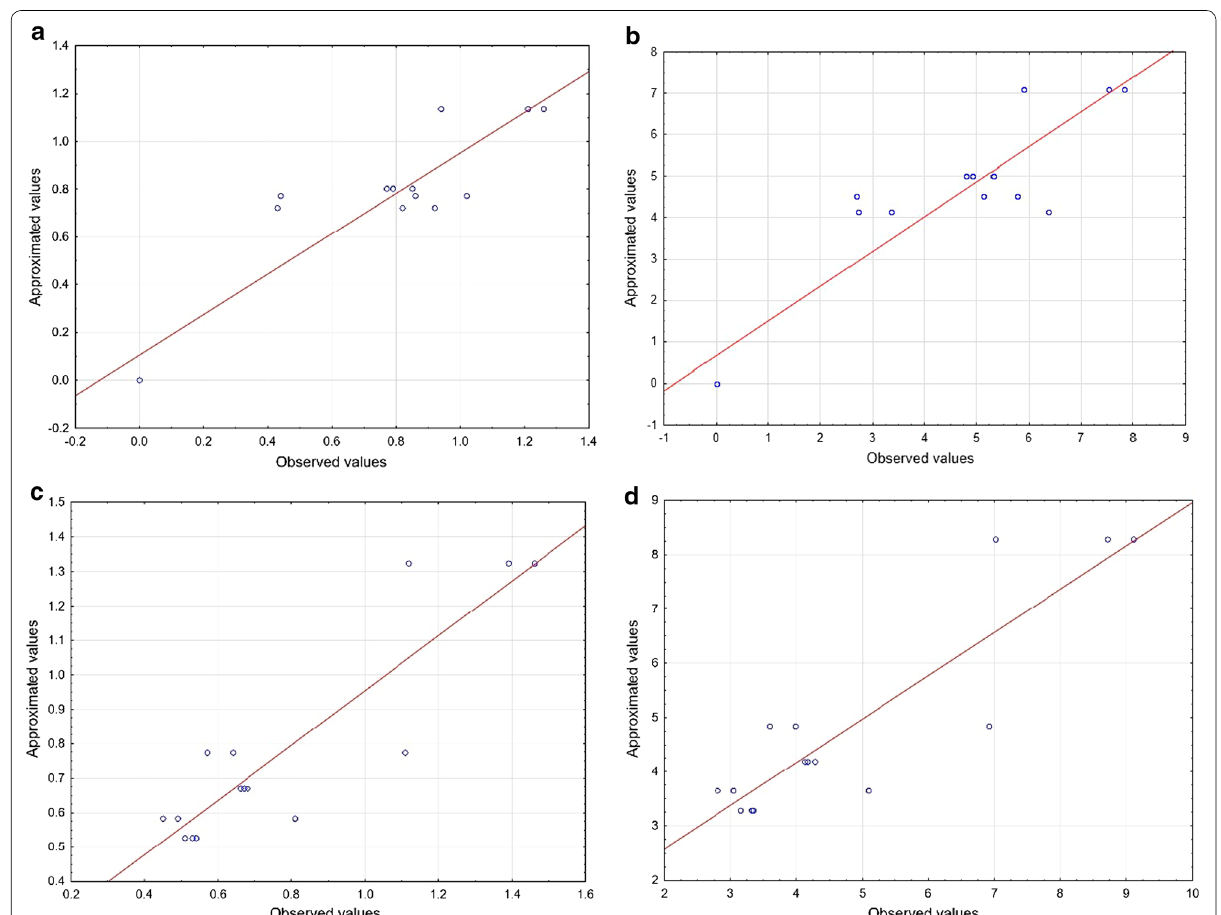
Fig. 1 Correlation of observed values versus approximate values of TN and TP for Yarrowia lipolytica strains cultured on the YPD medium. a TN ( Y. lipolytica ATCC 9793); b TP ( Y. lipolytica ATCC 9793); c TN ( Y. lipolytica A-101); d TP ( Y. lipolytica A-101). TN total nitrogen, TP total